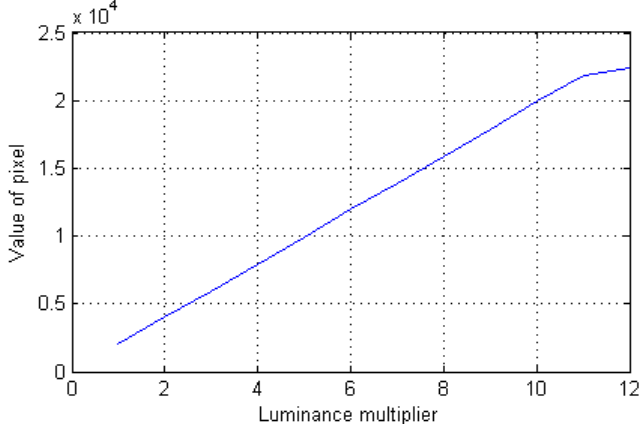
Figure 9. The relationship between the camera response and irradiance.